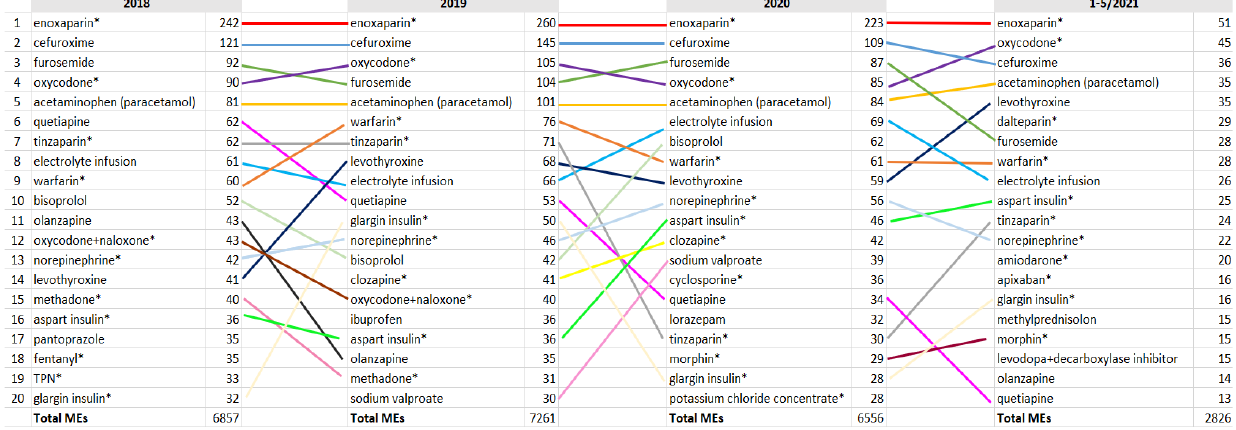
Figure 4. TOP20 medications related to the reported MEs in 2018 – 2020. * High-alert medication [7]. Another notable change to MEs related to levothyroxine, ranked 14th in 2018 vs. 5th